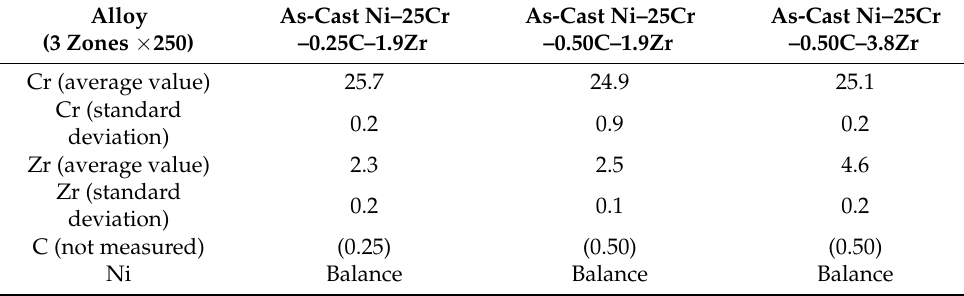
Table 1. Chemical compositions of the three Zr–containing alloys (wt.%, SEM/EDS; 3 × 250 full frame analyses, about 3 × 600 µ m 2